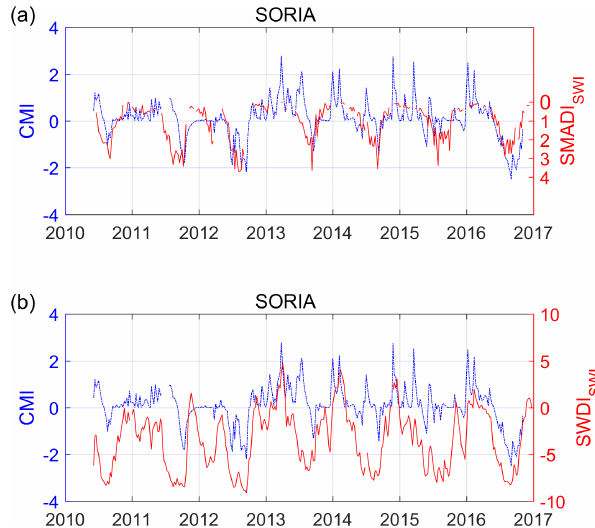
Figure 2. Time series of the weekly AWD and SMADI SWI (a) , and SWDI SWI (b) at the VA01 station of Inforiego, as an example. Since SMADI = 1 and AWD = 0 are the threshold for drought (Pablos et al., 2017), both values coincide in the y -axis. In addition, note that the y -axis of SMADI is oriented downward.